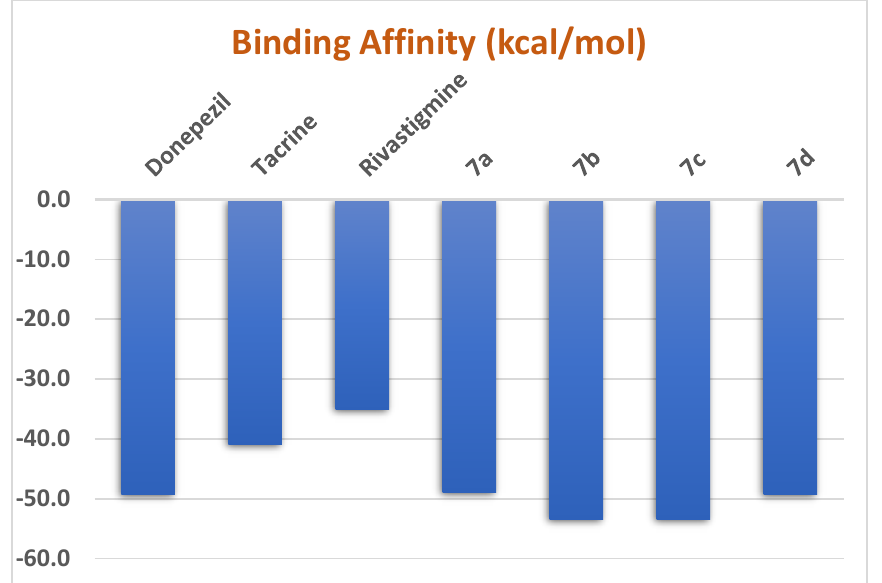
Figure 6. Comparison of the binding free energies of compounds 7a – d and the reference h AChE inhibitors donepezil, tacrine, and rivastigmine to the active site gorge of h AChE.